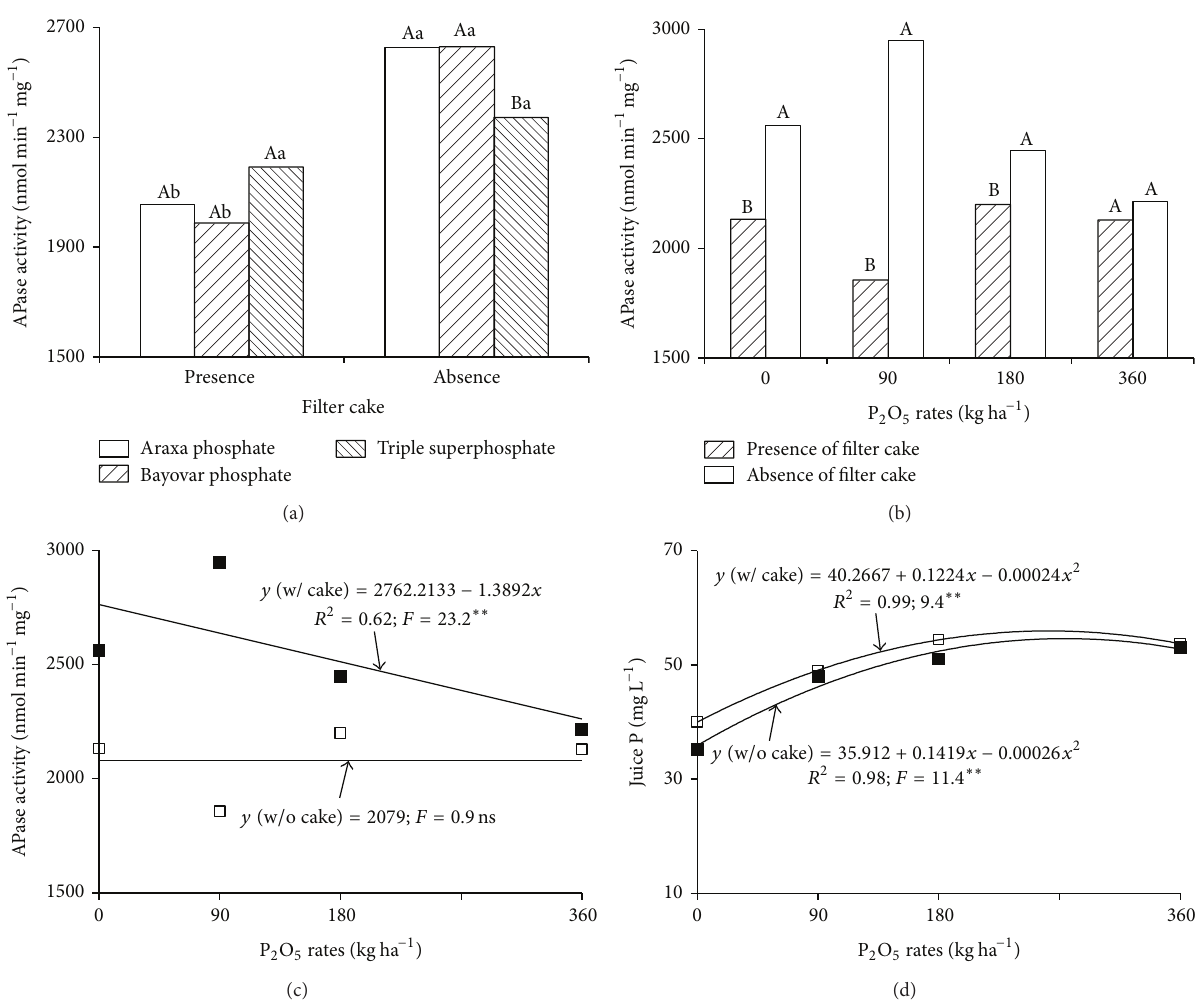
Figure 4: Acid phosphatase activity (APase), as a function of P sources and filter cake (a), P application rates and filter cake (b and c), and sugarcane juice P as a function of P application rates (d). Averages followed by single letters are significantly different (Tukey test, 𝑃 ≤ 0.05 ). Capital letters compare P sources with the effect of filter cake. Lowercase letters compare the effect of filter cake on each source. ∗∗ and ns: significant ( 𝑃 = 0.01 ) and insignificant,